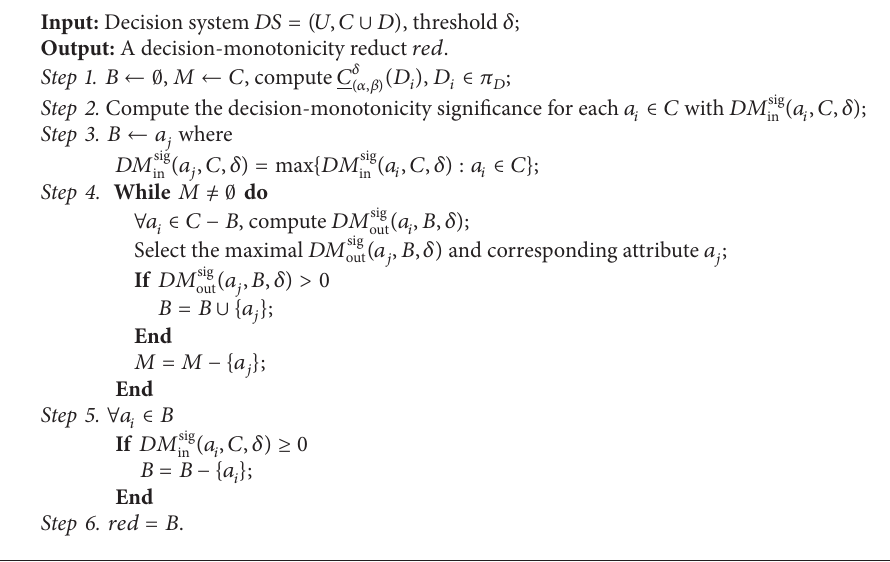
Algorithm 1: Heuristic algorithm for attribute reduction based on decision-monotonicity criterion.